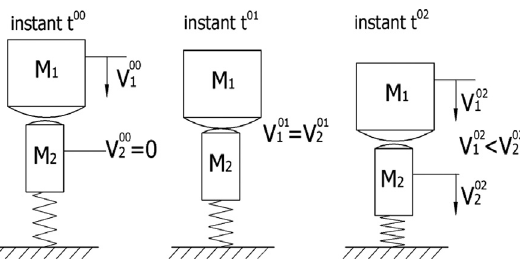
Fig. 8. Different stages of impact: (left) beginning of the compression stage, (middle) time instant when both velocities are equal, (right) end of the restitution